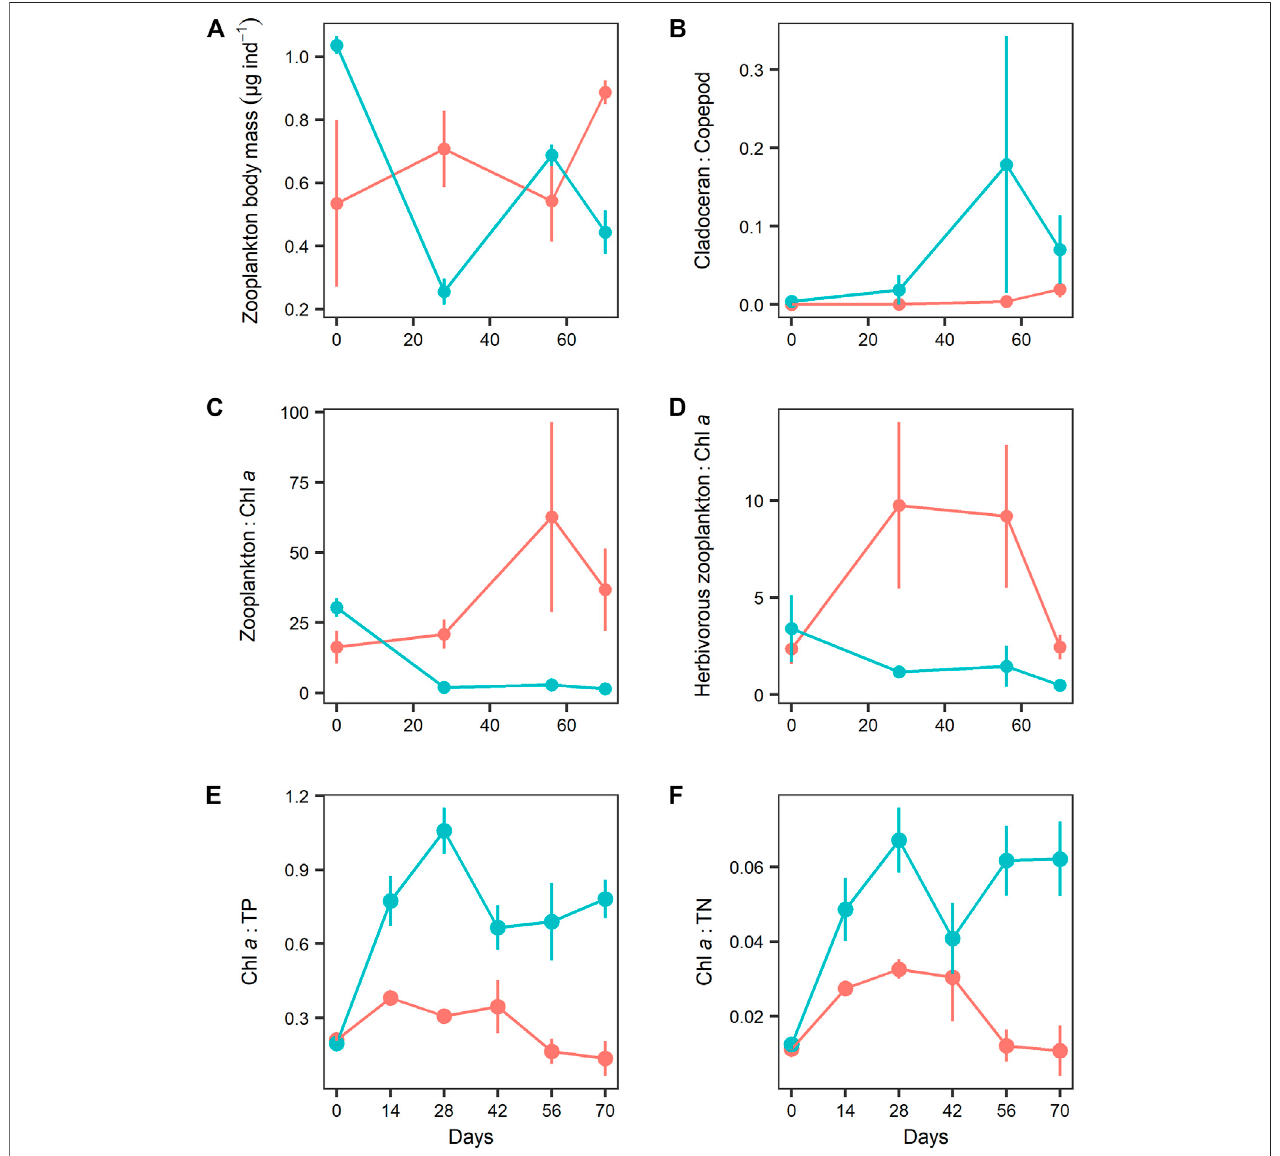
FIGURE 6 | Comparison of (A) average zooplankton body mass ( μ g dry weight per individual), (B) cladoceran to copepod biomass ratio, (C) zooplankton to chlorophyll a (Chl a ) ratio, (D) herbivorous zooplankton (without copepodites and adults of Mesocyclops leuckarti ) to Chl a ratio, (E) Chl a to TP ratio, and (F) Chl a to TN ratio. Between the two nitrogen treatments values represent mean ± SE ( n (cid:2)